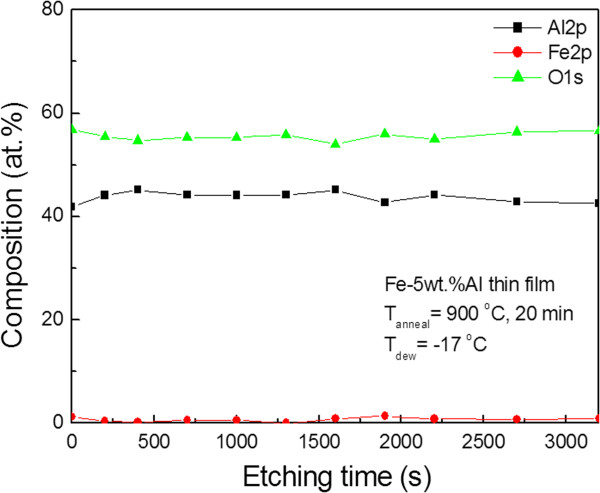
XPS depth profile of Fe-Al film oxidized for 20 min at 900°C. (TAnneal = 900°C, TDew = -17°C, and t = 20 min).